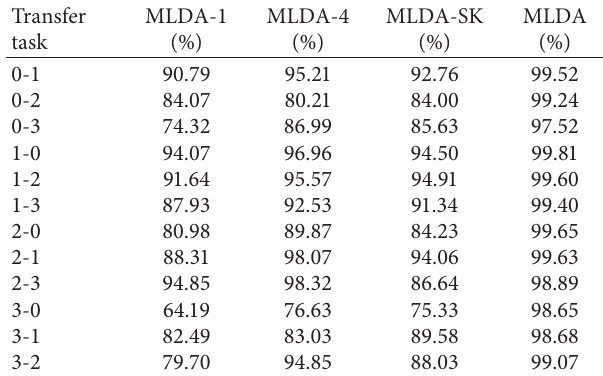
Table 4: Experimental results of different parameter settings. Transfer